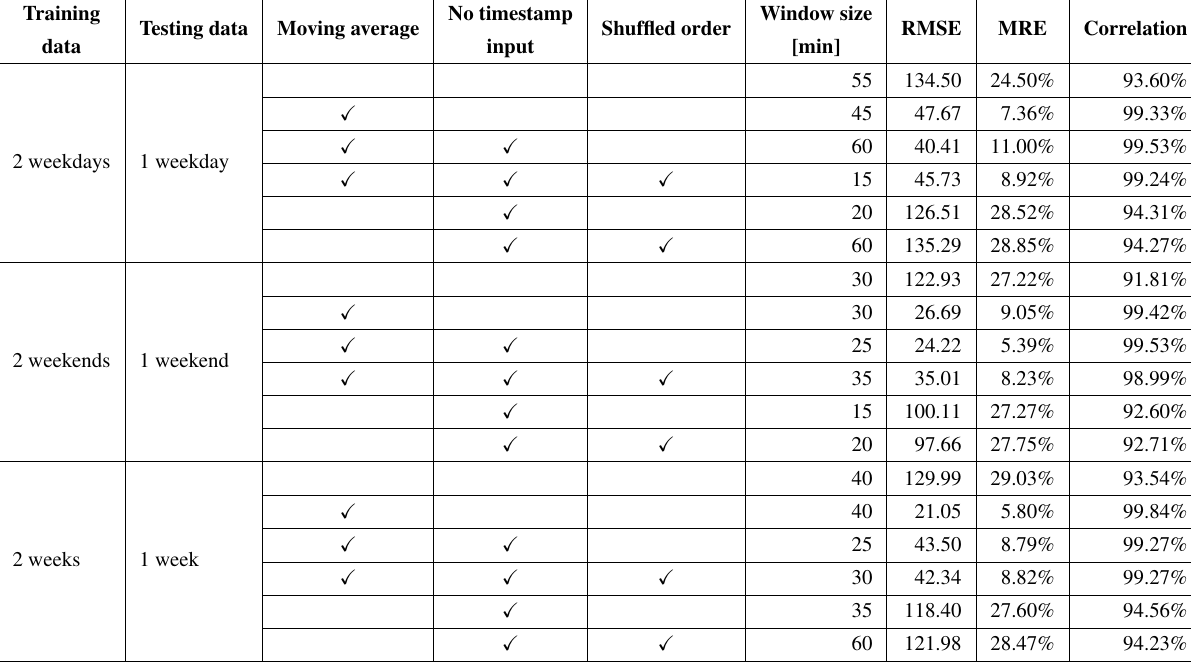
Table 3. Summary of vehicular flow prediction errors on different datasets using Deep Learning with different pre-processing schemes pre-processing and prediction of traffic intensity time series can be easily adapted to other time series with minor modifications as per the domain of